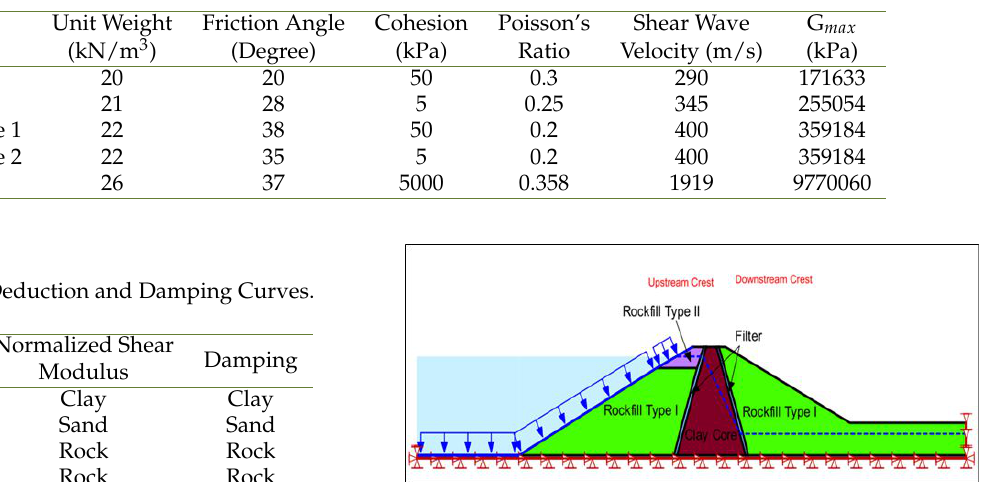
Table 1. Material proportions of concrete specimens.